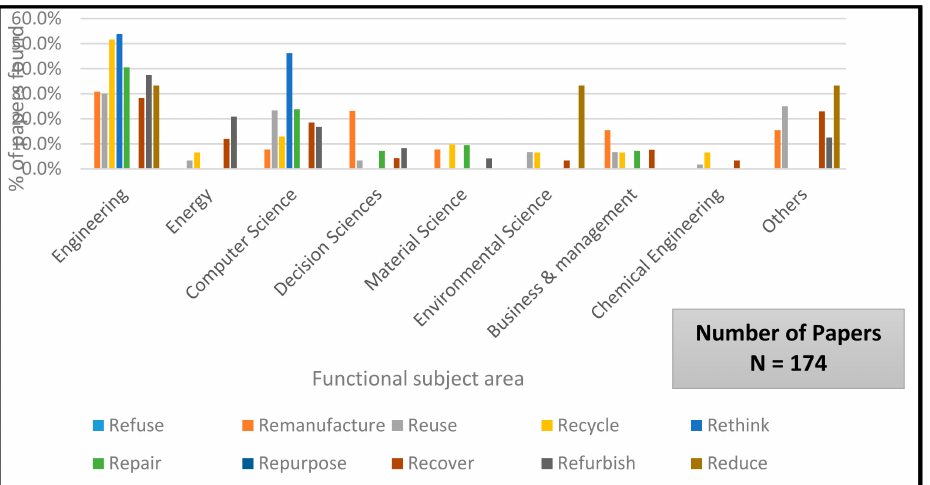
Figure 10. Papers distribution across subject area and circular